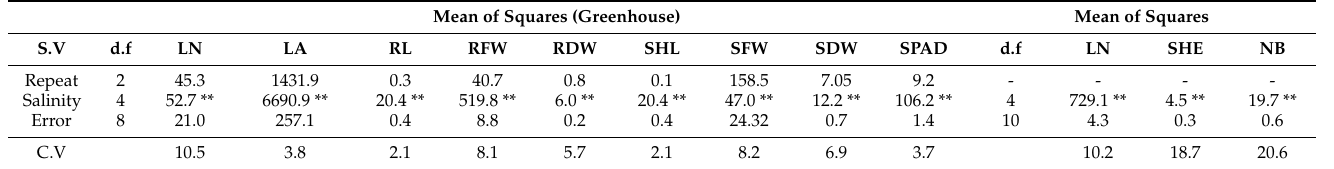
Table 1. ANOVA of salinity stress effect on growth parameter measured in the greenhouse and in vitro. Mean of Squares (Greenhouse) Mean of Squares